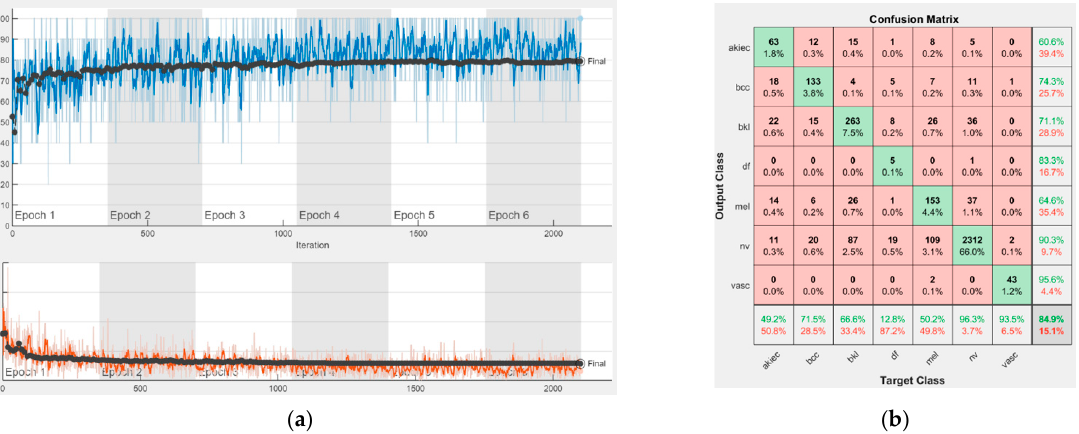
Figure 9. Results using GoogLeNet pre-trained on ImageNet, ( a ) Accuracy and loss, ( b ) Confusion matrix.